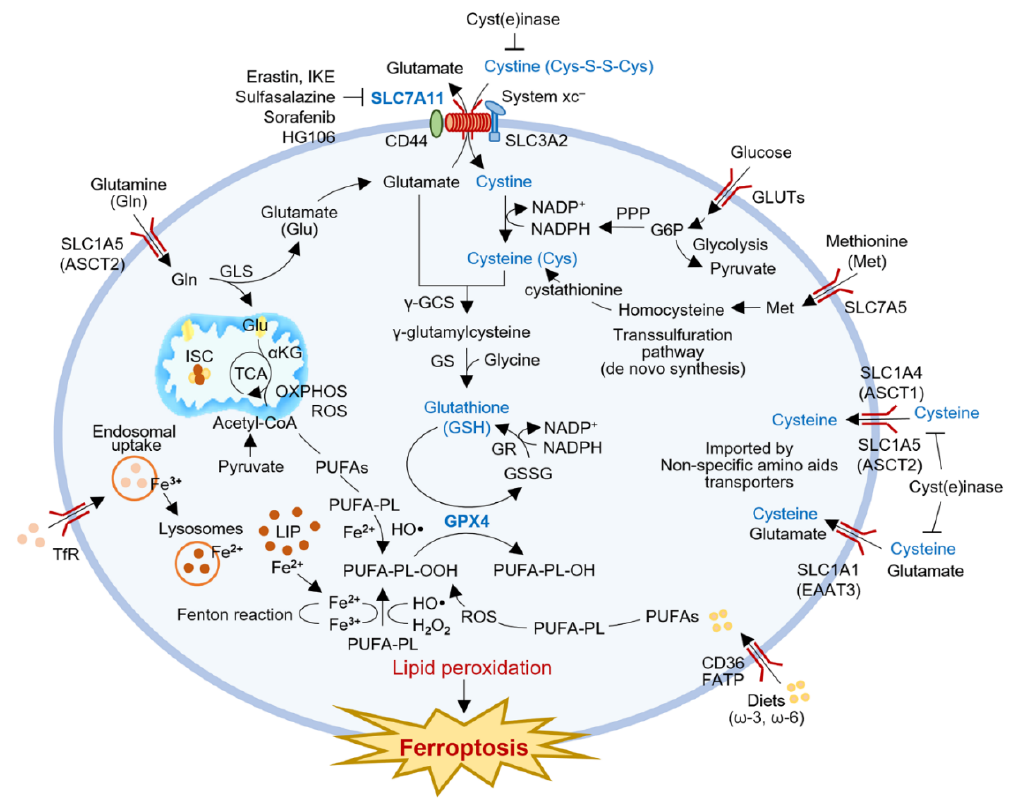
Figure 1. Role of SLC7A11-GSH-GPX4 axis in redox signaling and ferroptosis induction. SLC7A11